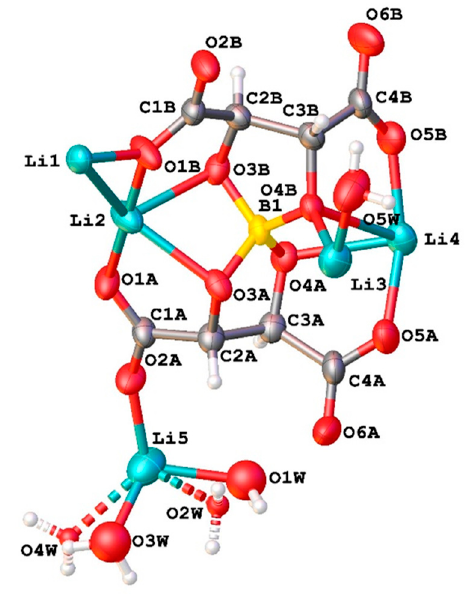
Figure 3. View of the asymmetric unit of compound Li 5 T 2 B.